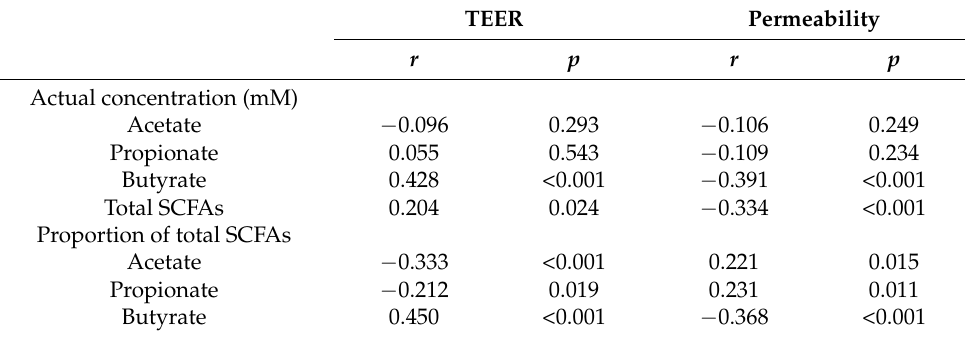
Table 2. Correlations between cellular parameters (TEER and permeability) and SCFAs. 219